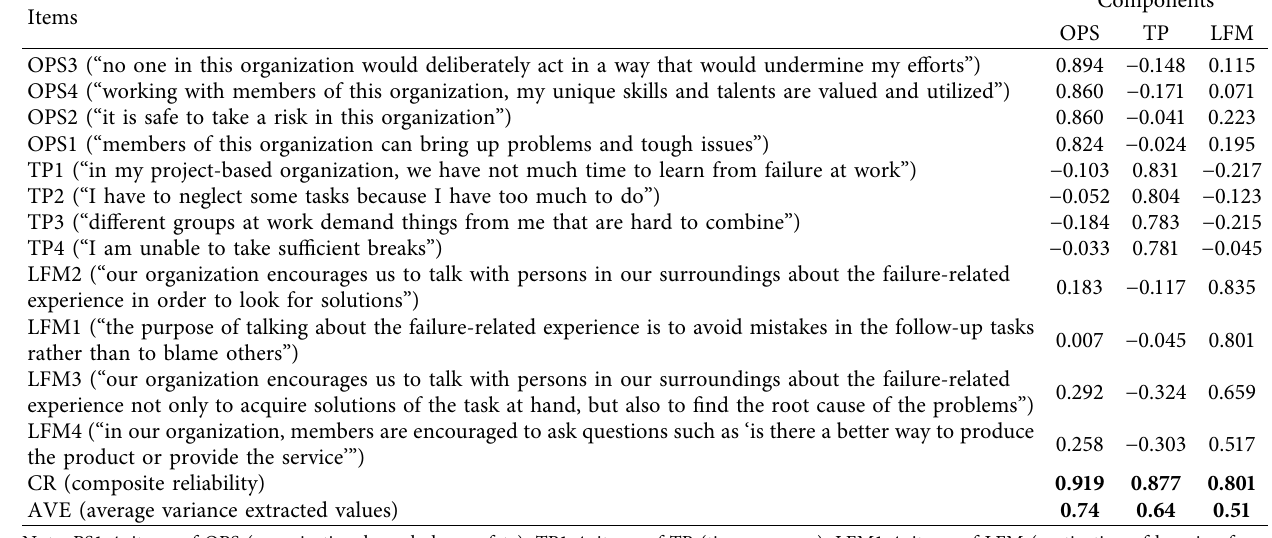
Table 2: Factors’ loading matrix, CR and AVE values ( N � 189).